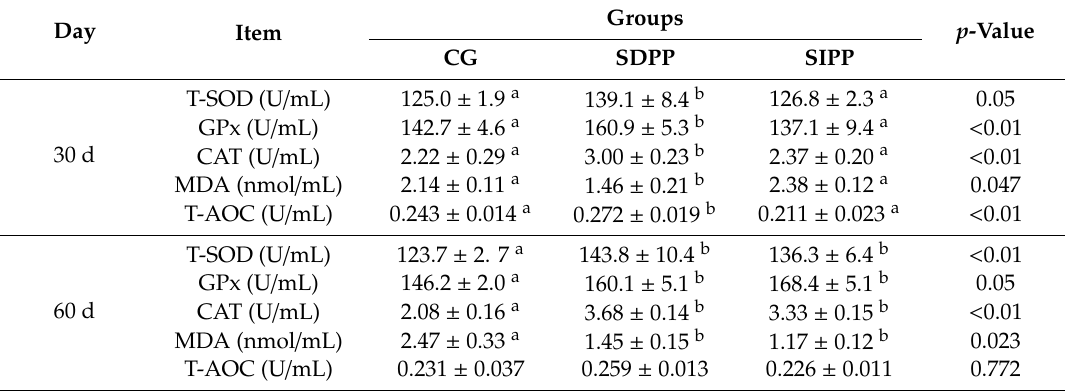
Table 3. E ff ects of photoperiod change on antioxidant status indicators.